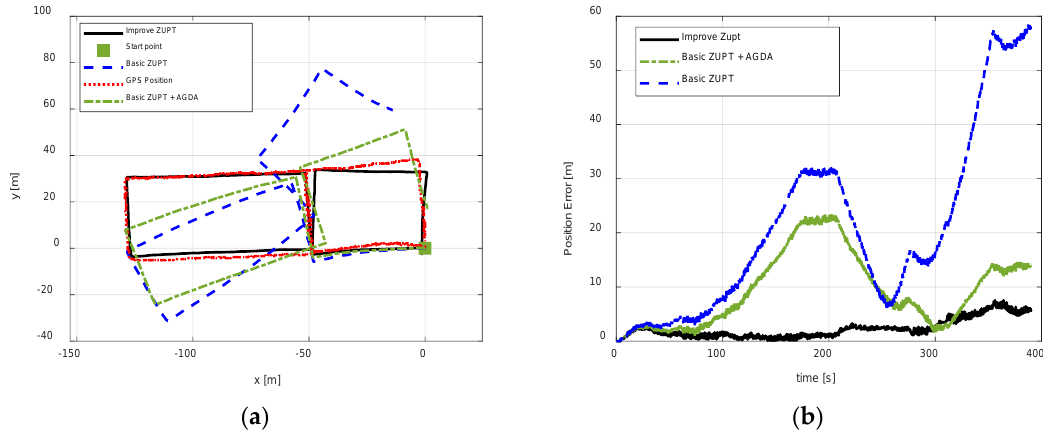
Figure 9. Position result for test 1. ( a ) Trajectory tracked result; ( b ) position error by different algorithms.